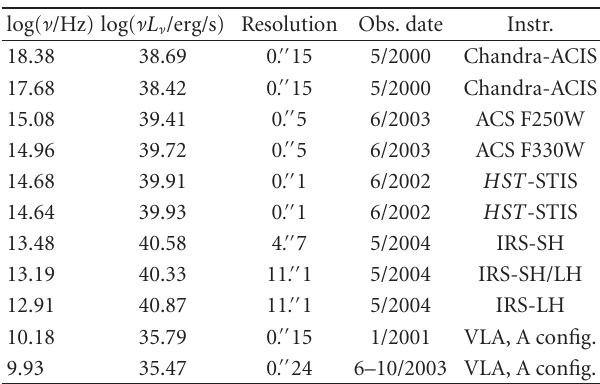
Table 3: Nuclear SED